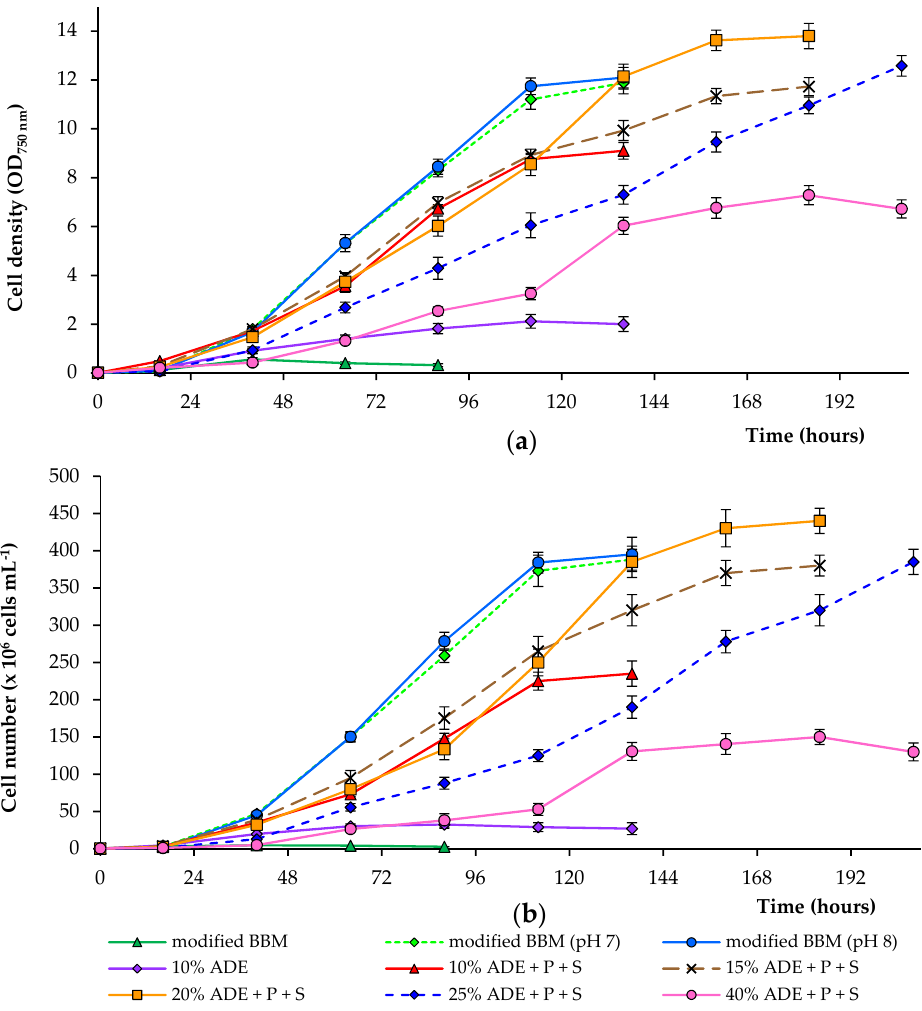
Figure 1. Growth of C. sorokiniana AM-02 (OD 750 ( a ) and cells · mL − 1 ( b )) cultured under different conditions.